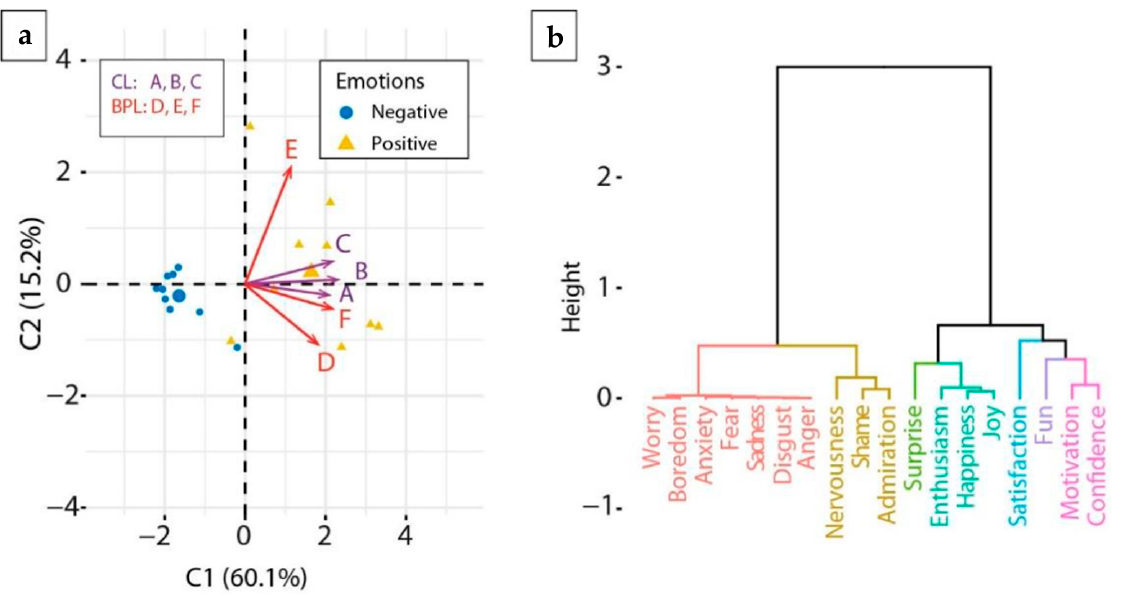
Figure 1. ( a ) PCA result of categories as variables and emotions as individuals. Both CL variables (A, B, C) and BPL (D, E, F) are associated with positive emotions distribution. ( b ) Emotion cluster- ing.